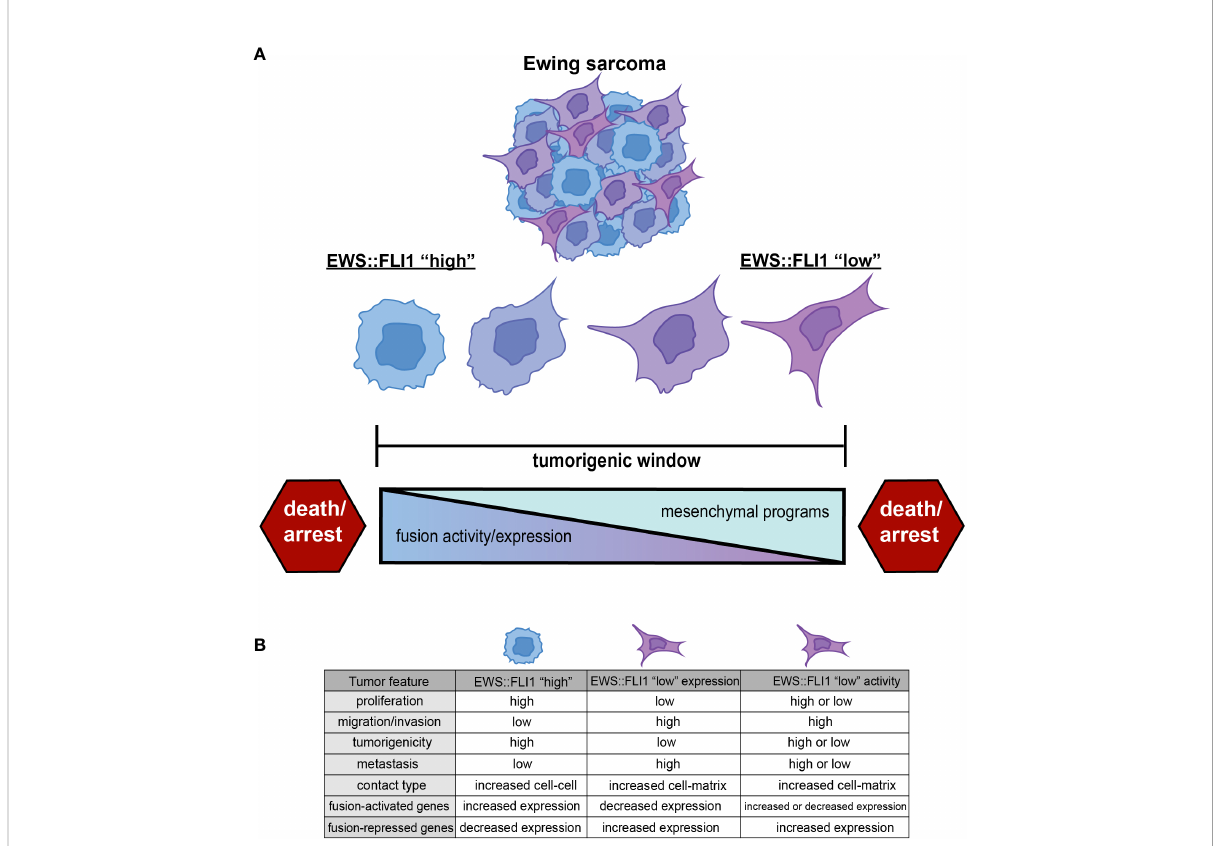
FIGURE 1 (A) Ewing sarcoma cells exist along a spectrum of EWS::FLI1 expression and activity states. Ewing tumors consist of different populations of these cells, and epigenetic plasticity allows cells to shift along this axis within the tumorigenic window. EWS::FLI1 activity above or below a permissive window leads to growth arrest and death, consistent with the “ Goldilocks ” principle (19). (B) EWS::FLI1 “ high ” cells have increased proliferation, tumorigenic potential, and exhibit more cell-cell contact. EWS::FLI1 “ low ” cells have increased migration/invasion, metastatic potential, and enhanced extracellular matrix association (17 – 25). EWS::FLI1 “ high ” and “ low ” cells have an inverse expression pattern of fusion- regulated genes. EWS::FLI1 “ low ” activity cells have increased expression of the repressed signature, but can have either high or low expression of the activating signature. Figure created with